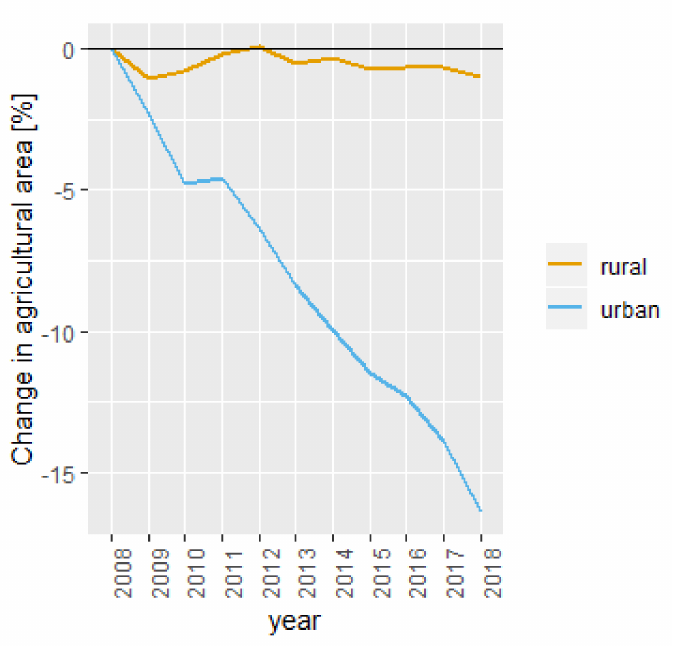
Figure 3. Change in agricultural area from 2008 to 2018 in rural (orange) and urban areas (blue). The change was calculated as = ((agricultural area in year i-agricultural area in 2008)/agricultural area in 2008) × 100. (Data source: